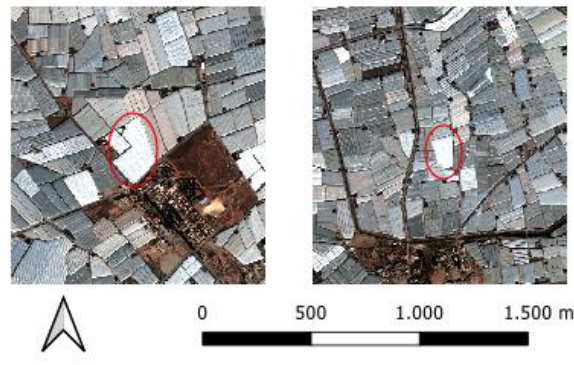
Figure 9 . Whitewashed greenhouses marked with red ellipses over a WV3 image taken on December